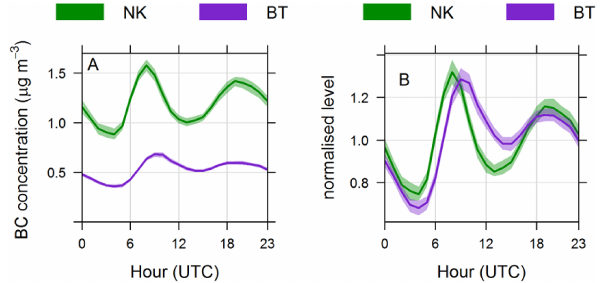
Figure 10. Mean diurnal cycles of the mean (a) and normalised (b) BC concentrations (880nm) over the whole sampling period at the London sites. For plot B the values were normalised to the mean. Note BC concentrations were measured by a 2W AE at NK and a 7W AE at the BT tower, with the same correction factor applied to both instrument data sets.